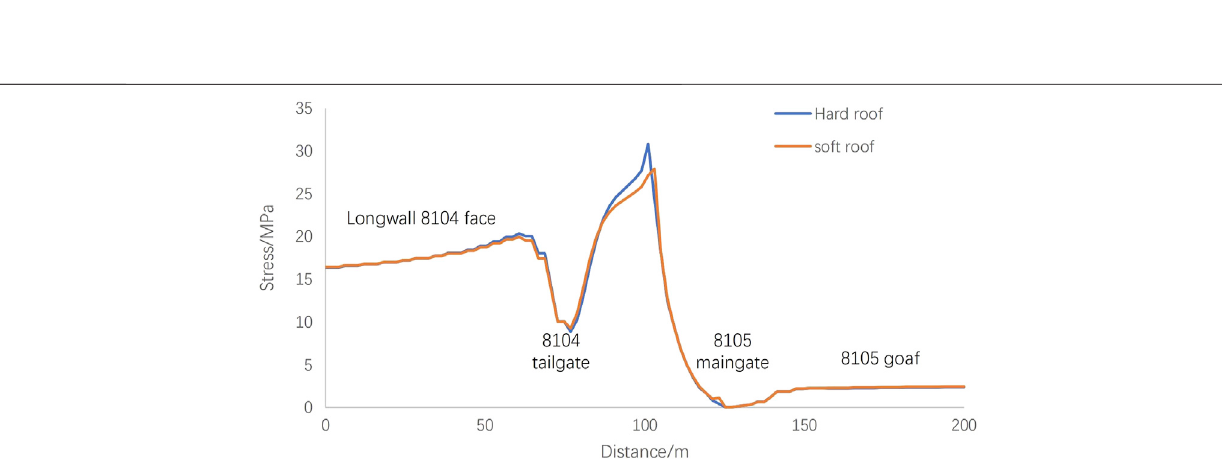
Frontiers in Earth Science |